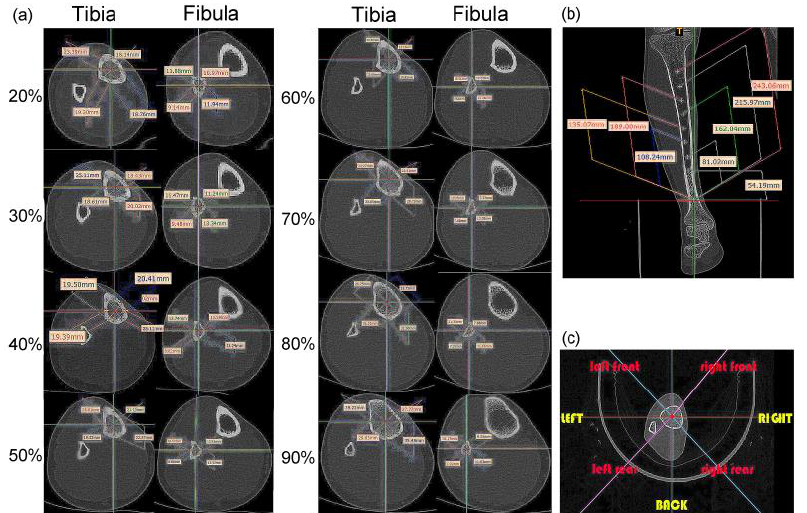
Figure 2. Location and shape selection of human tibiofibular sections: ( a ) size data of the tibia and fibula at different positions; ( b ) overall size division of the calf bone; ( c ) division of eight azimuth points.